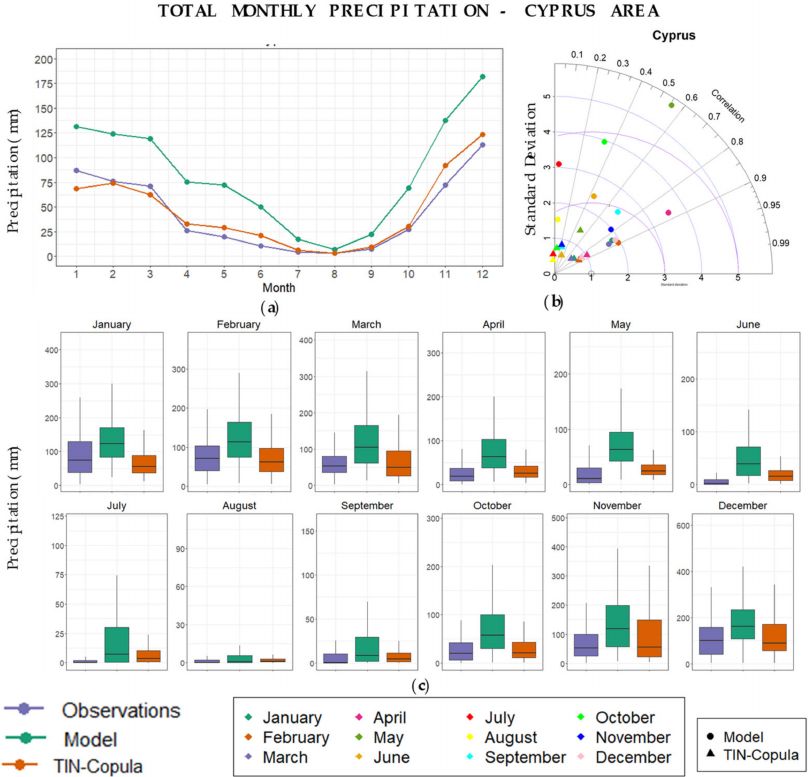
Figure 6. Monthly mean total precipitation values in Cyprus for the period of 1986–2000. Presentation with ( a ) line plots, ( b ) Taylor diagram and ( c )